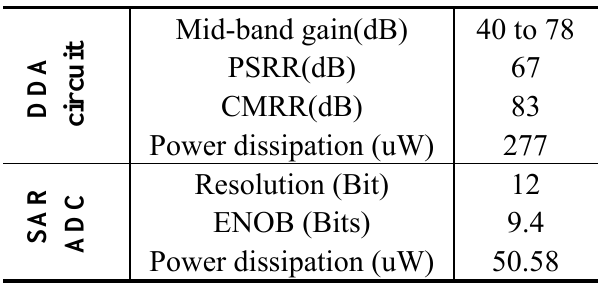
Table 3. Performance summary of the bio-potential acquisition